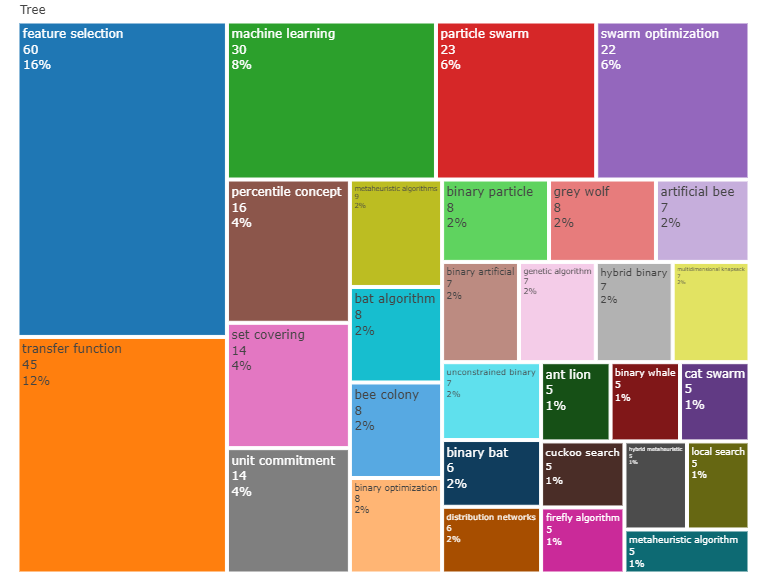
Figure 4. The most relevant bigrams, Treemap.